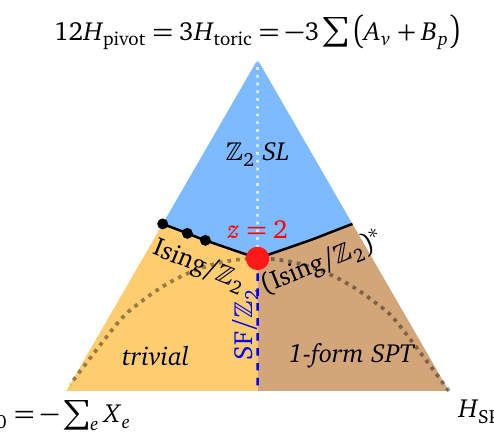
transition as a 1-form SPT transition in 2 + 1 dimensions. We Figure 6: BEC / (cid:90) 2 use the toric code on the square lattice as a pivot to construct an SPT phase: i.e., (cid:1) = − (cid:80) / 4 ) = exp (cid:0) − i π H H UX U † with U = exp ( − i π H . The central e SPT toric pivot e vertical axis has a U ( 1 ) symmetry generated by the toric code itself. In particular, tuning by H leads to a BEC transition of the m -anyon; correspondingly, the red toric dot is a direct SPT transition described by a gauged version of the dilute Bose gas = 2. The rescaling factor of 12 is included to BEC / (cid:90) , which we denote by z 2 dyn improve presentation in barycentric coordinates, such that the 2 + 1 D Ising transitions at the edge of the triangle are now roughly halfway the edges. The three black dots for the Ising transition were obtained in Ref. [ 75 ] for the dual XY model. The white dotted line has the toric code state as its ground state; this also holds for the z = 2 multicritical point. The black dotted line gives a frustration-free path where the ground state admits an exact PEPS representation with virtual bond dimension + b ( 3 H ) + cH D = 2. More precisely, writing H = aH , the solvable line is 0 toric SPT (cid:112) a ( 1 − a ) . This includes the BEC / (cid:90) the one-parameter family c = 1 − a and b = 4 2 3 transition at a = c = 1 and b = 2 , where the ground state is given by the fixed-point 2 3 toric code wavefunction. The two Ising ∗ transitions are distinct symmetry-enriched